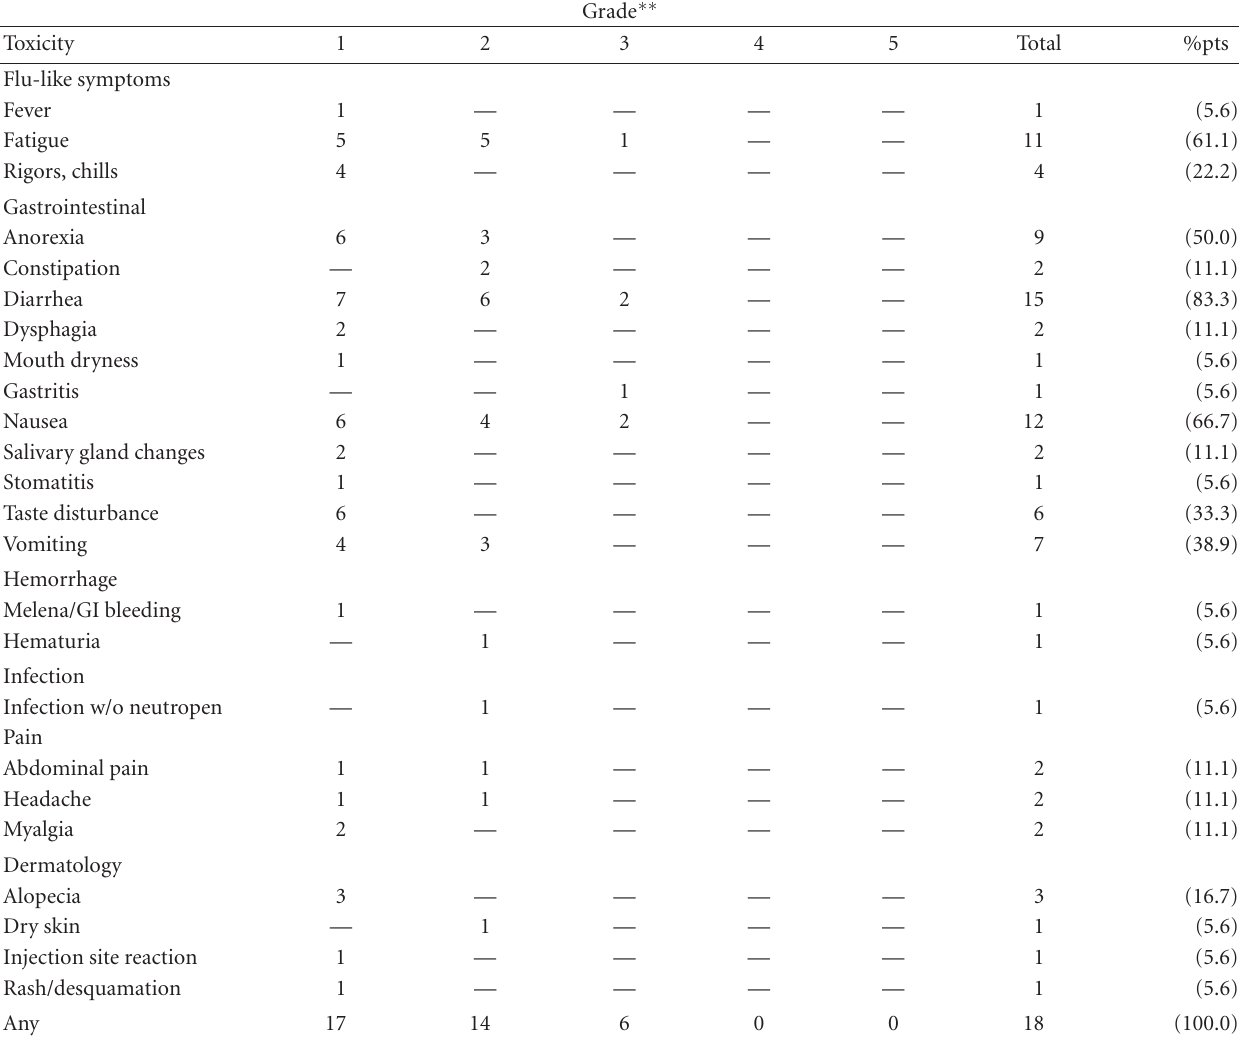
Table 3: Treatment-related (cid:0) nonhematologic toxicities (worst by patient) ( n = 18 patients). Grade (cid:0)(cid:0)